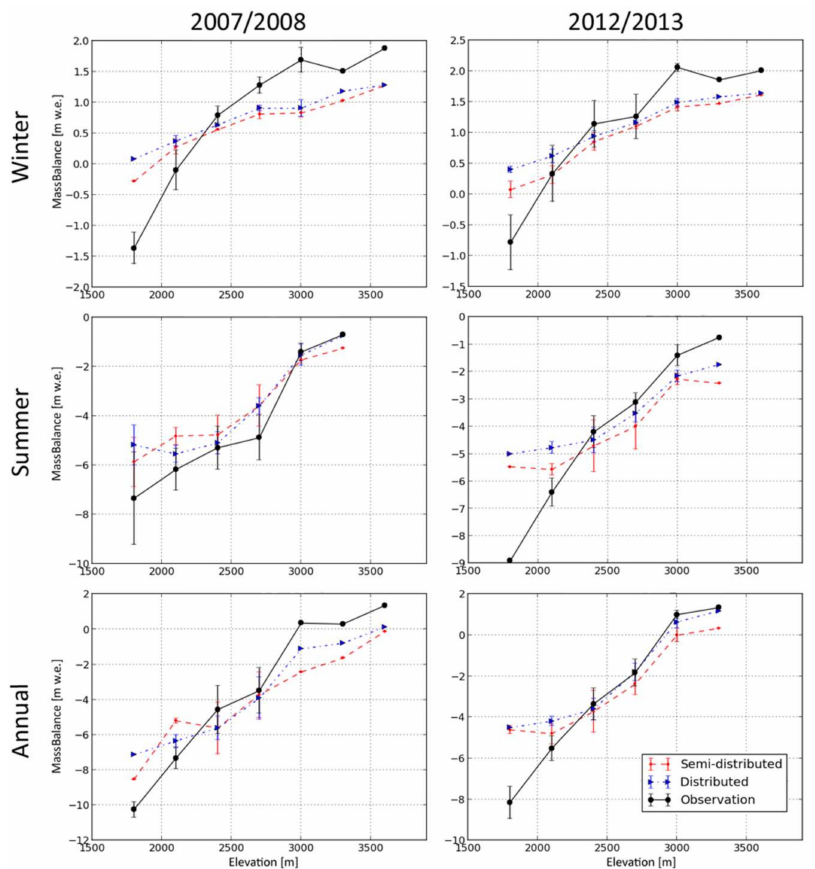
Figure 12. Altitudinal dependence of the observed and simulated (semi-distributed and distributed) SMB for two snow seasons (2007–2008: low level snow accumulation; and 2012–2013: high level snow accumulation) at the Mer de Glace